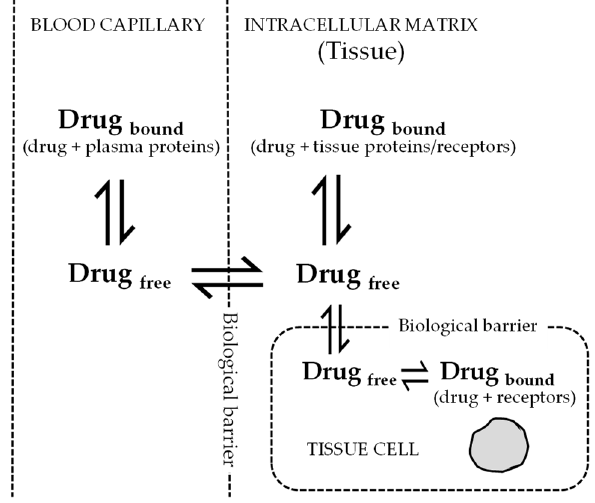
Figure 2. Distribution of unbound (free) drug across membranes at equilibrium. According to free drug theory (FDT), the free drug concentrations across di ff erent compartments (blood capillary, in- tracellular matrix, and tissue cells) are same at equilibrium. The dynamic equilibrium is also main- tained between the free drug with the proteins/receptors present in that particular compartment. Only the free drug exerts a pharmacological response when bound to receptor.